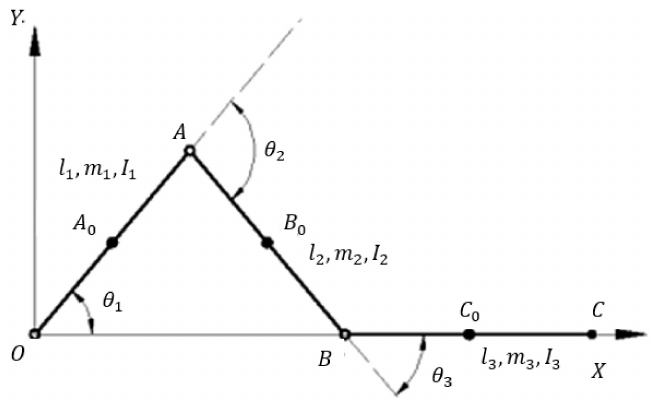
Figure 17. Model for dynamic